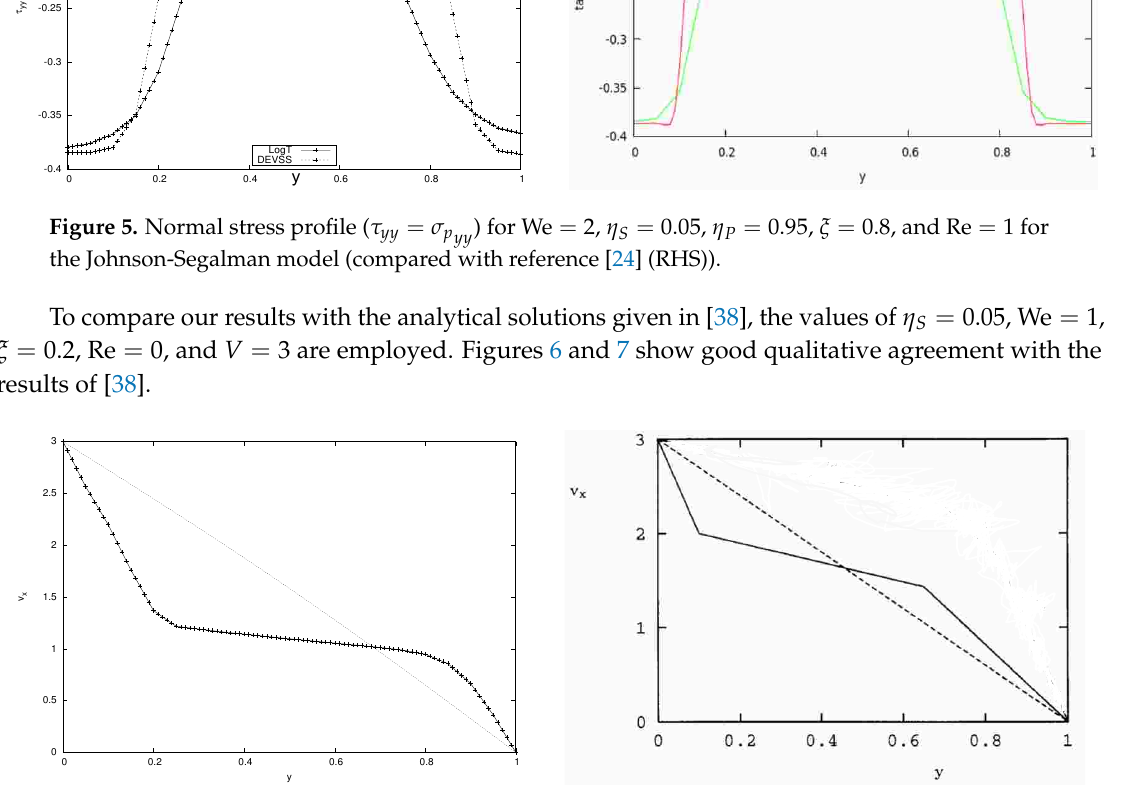
Figure 6. Velocity profile for We = 1, η S = 0.05, ξ = 0.2, We = 0, and V = 3 (compared with the analytic solution from reference [38] (RHS)). The dashed line is the final